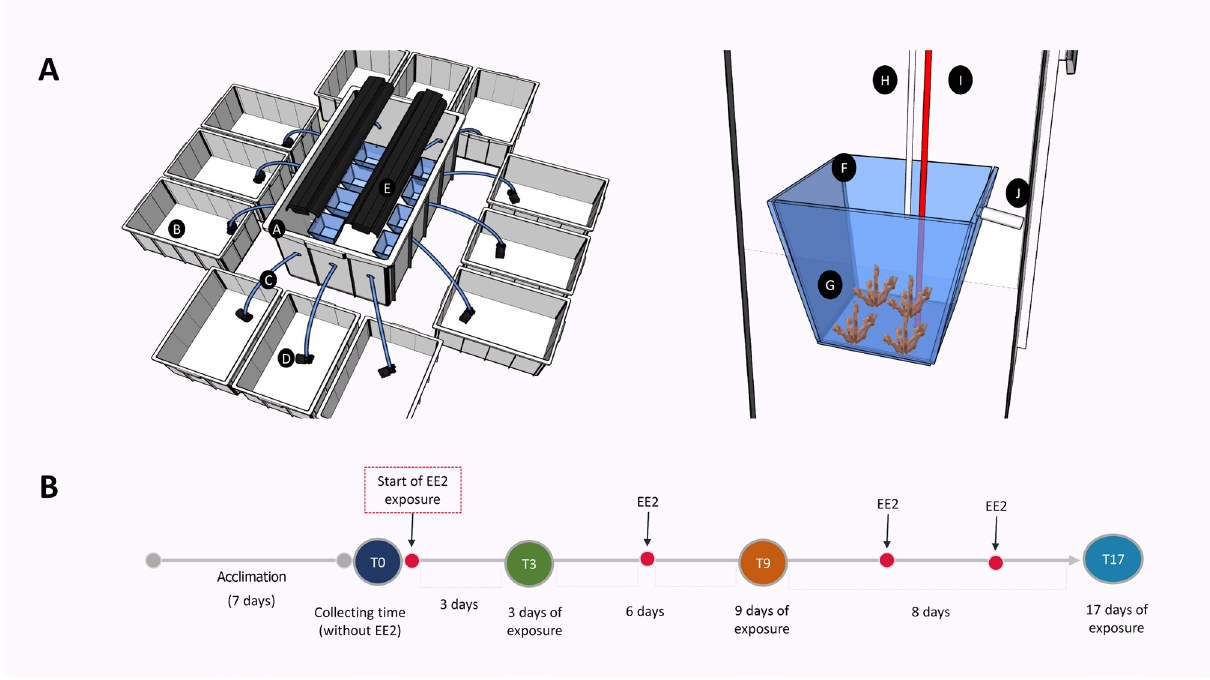
Figure 5. ( A ) Schematic representation in 3D modeling of the microcosm, using the software SketchUp. The letters indicate the parts of the structure. A. Water-bath; B. Treatment sumps; C. Aquarium supply hose; D. Circulation pump; E. Illumination system (2 fluorescent lamps and 2 blue lamps); F. Aquarium; G. Four fragments of Mussismilia harttii ; H. Aquarium supply hose; I. Air entrance hose; J. Overflow. ( B ) Timeline showing an overview of the